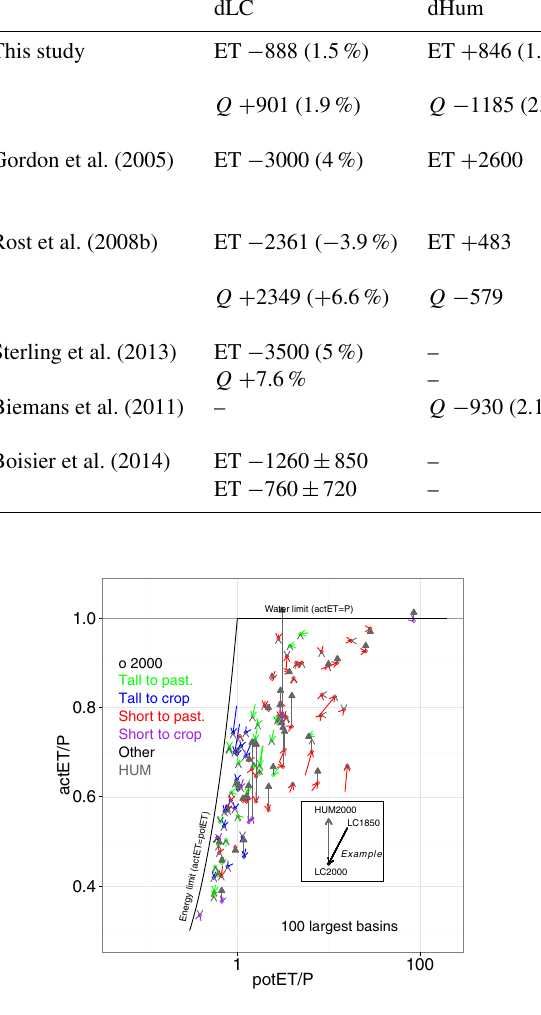
Figure 10. Annual climatological means of actET /P ( y axis) and potET /P ( x axis) for the 100 largest river basins (on our model grid). The x axis is on a log scale. Circles represent actET /P and potET /P for the LC2000 experiment, colors indicate the land cover change, and gray is for human water use. Arrows point from values for the LC1850 to those for the LC2000 experiment (colors), or from LC2000 to HUM2000 (gray), see the example. Solid arrow- heads indicate that the change in actET /P induced by human water use is larger than the change induced by land cover. This occurs in 33 of the 100 basins. Here we reclassified the land cover changes for the entire basins; we did not group the subbasins that were used in Sect. 3.3. Figure A7 shows which basins were used for this Budyko